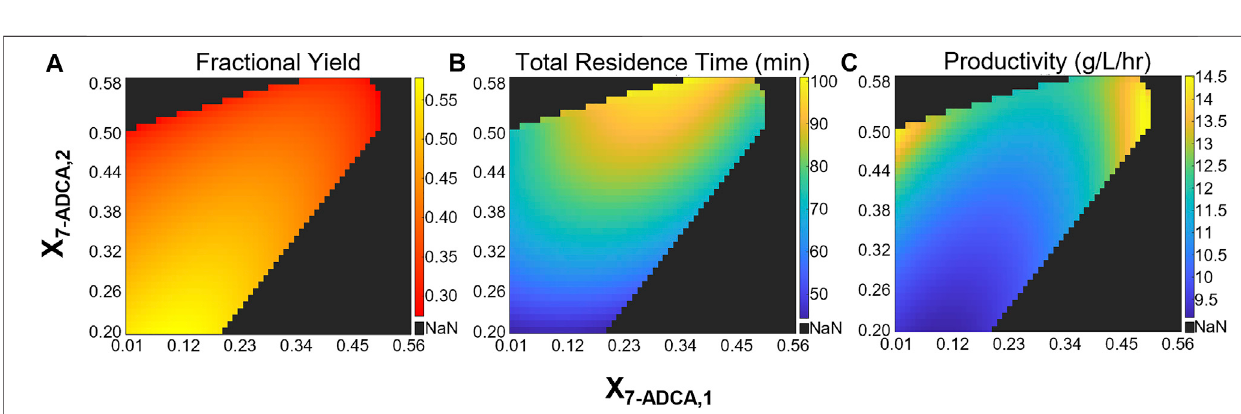
Frontiers in Bioengineering and Biotechnology |